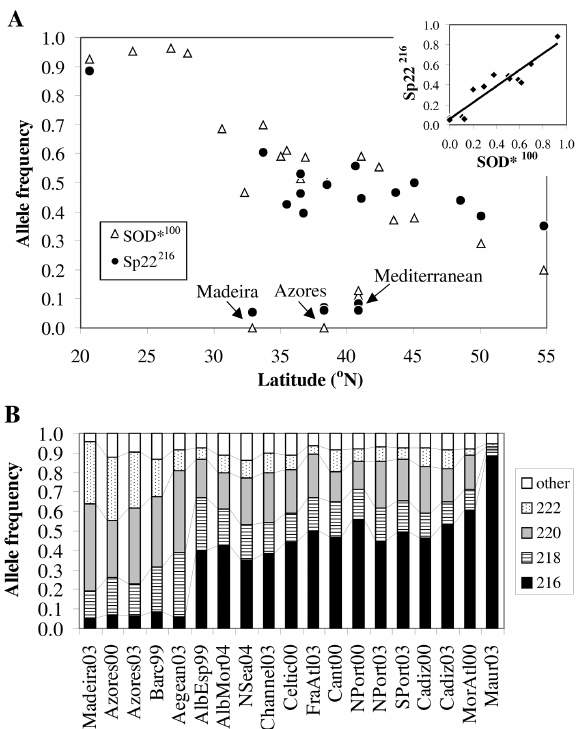
Fig . 4 – A, allelic frequencies for allele 216 of microsatellite locus Sp22 and for allele 100 of allozymic locus SOD* from different sardine samples plotted against the latitude. Data for SOD* are from Chlaida et al. (2006) and Laurent et al. (2007). The embedded graph displays the correlation between these 2 alleles. B, allelic frequen- cies of microsatellite locus Sp22 in the different